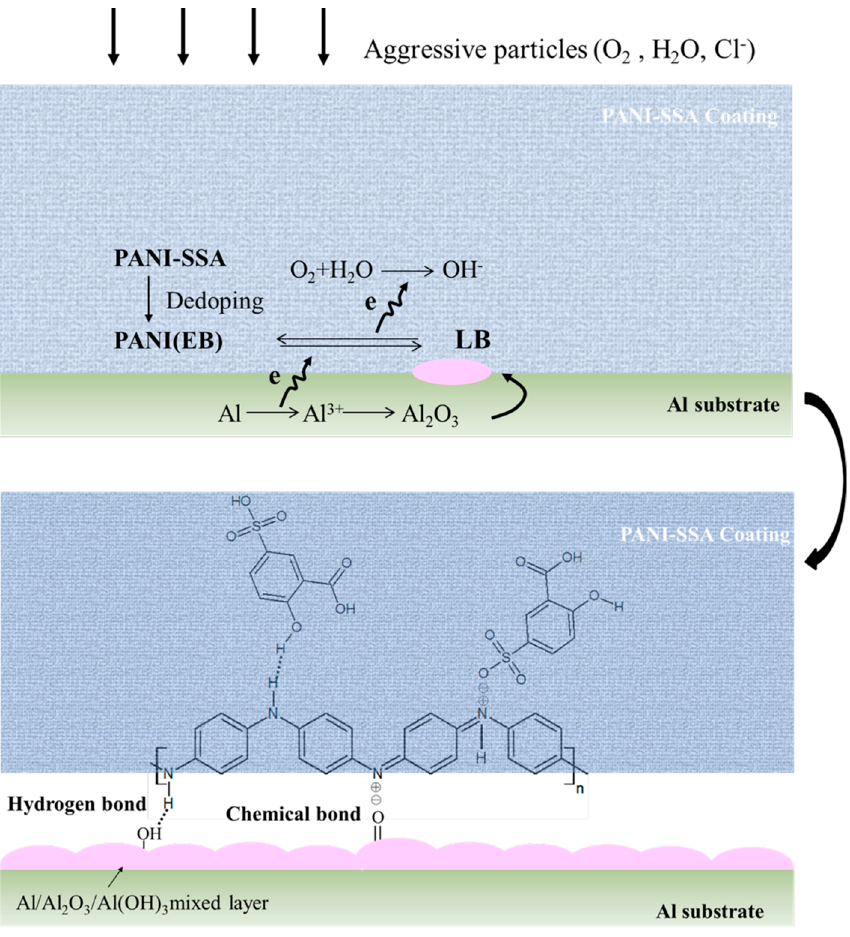
Figure 13. Schematic protection mechanism of the epoxy with PANI-SSA for 5083 aluminum alloy in 3.5% NaCl solution.